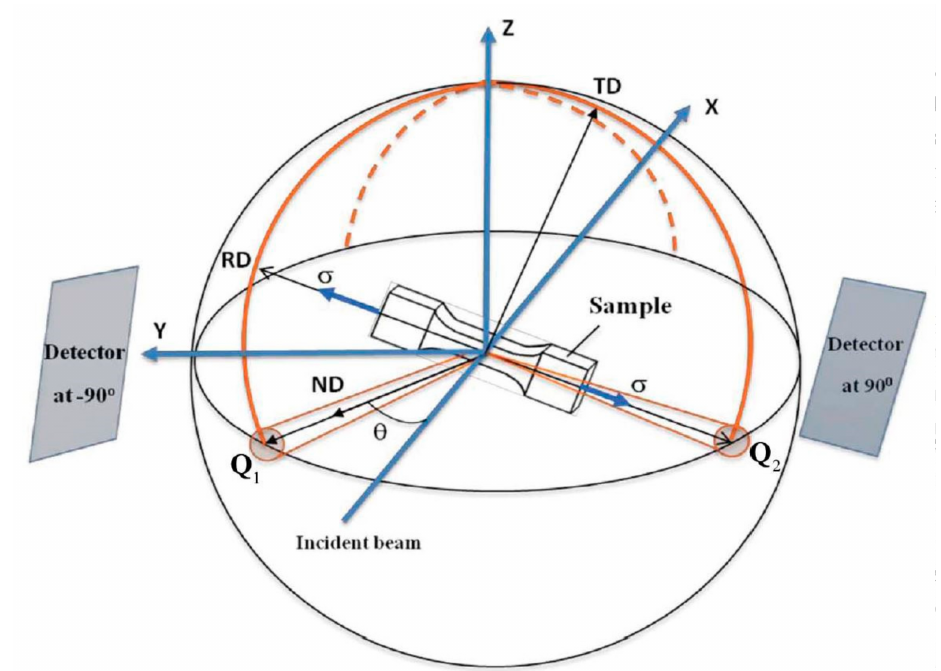
Figure 3. Schematic for the in situ measurements (loading) for the VULCAN di ff ractometer: XYZ is the instrument coordinate system, xyz is the sample coordinate system (identified, respectively, with the main processing directions: rolling (RD), transverse (TD), and normal (ND)), σ is the mechanical loading along the RD, θ is the di ff raction angle, and Q1 and Q2 are the scattering vectors [32]. Reproduced with permission of the